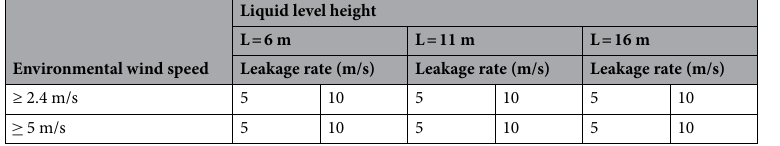
Table 2. Example settings (environmental parameters remain unchanged).